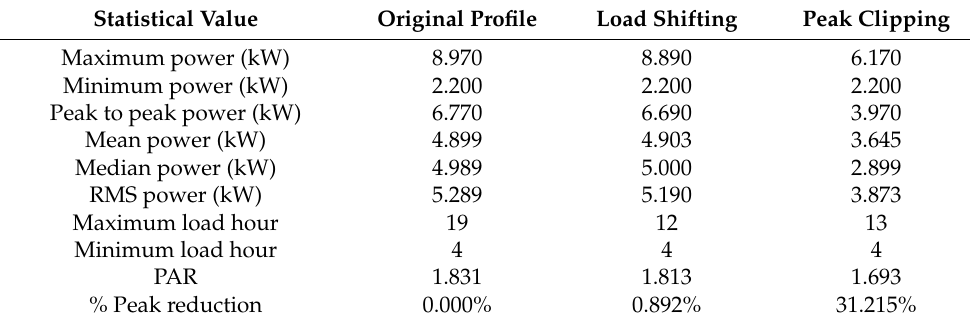
Table 3. Statistical parameters of profiles before and after DSM.